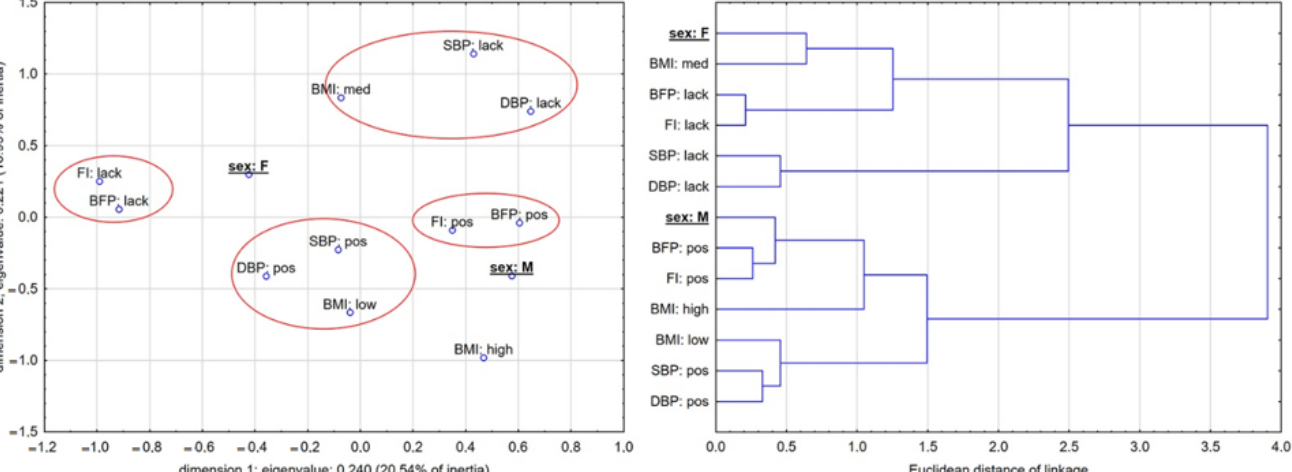
Figure 2. Co-occurrence of the changes in independent variables in the control group concerning sex and BMI status . Taxonomical dendrogram illustrates similarities and distances (strength) of link- ages. Figures 1 and 2(EG and CG, respectively) present a clear separation between boys and girls (in both EG and CG) in the co-occurrence of changes in measured parameters. This indicates that SEX differentiation corresponds between categories of factors and var- iables independently of the intervention program. However, the picture of associations is quite different between EG and CG. In EG, the HIIT intervention response was higher in the male group. Girls more often exhibited a lack of changes in FI and BFP. Those catego- ries of variables were very closely related. Boys from the low category of BMI status more often exhibited positive changes in cardiovascular parameters. The structure and strength of similarities (based on distances between categories) are shown in dendrogram drawn using Ward’s method and Euclidean linkage distances. The FI and BFP categories were